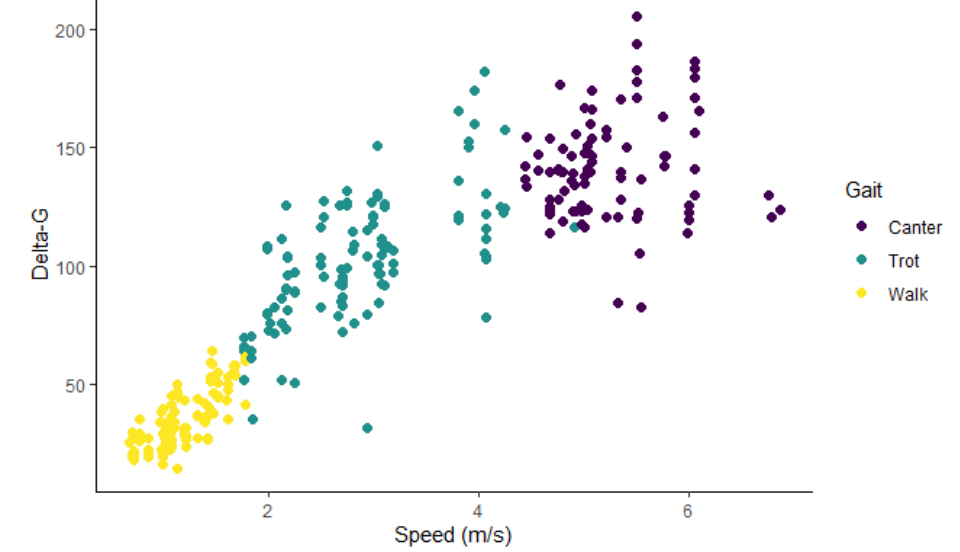
Figure 4. Plot of delta-G and speed with the distribution of the three gaits, walk, trot and canter. Data from 311, 10 s intervals of seven Huntaway dogs on a treadmill.